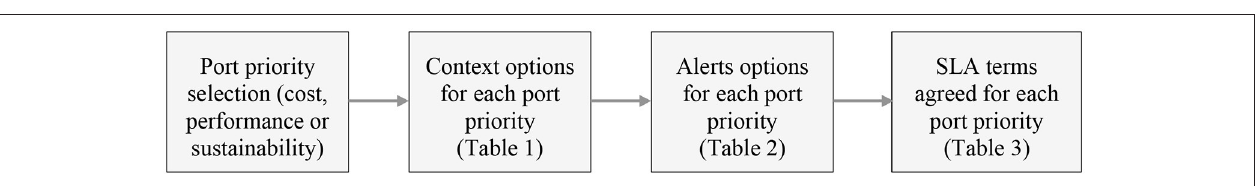
FIGURE 3 | Port SLA service tiers.